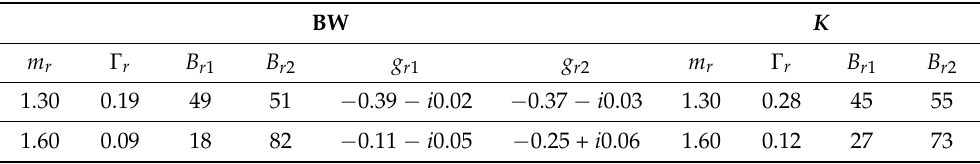
Table 3. BW and K-matrix parameters for data in Figure